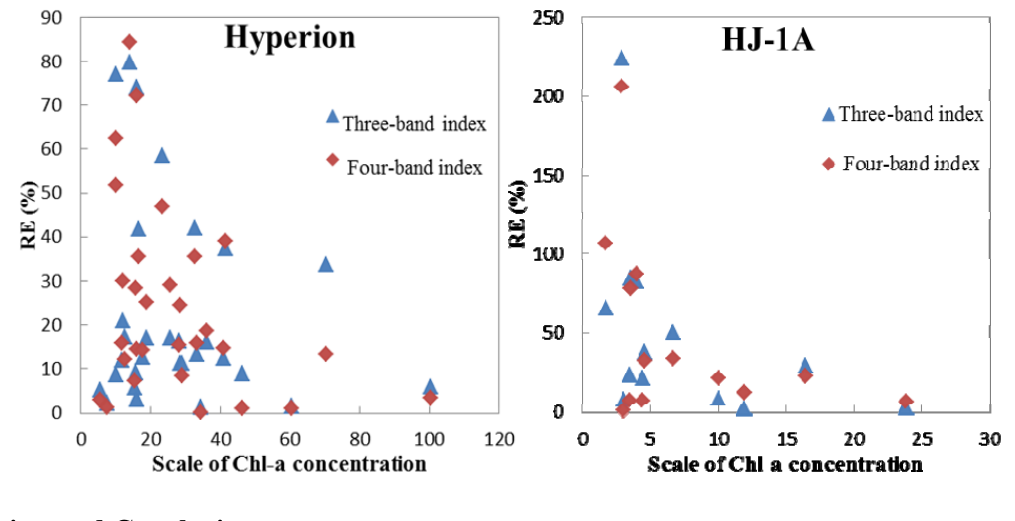
Figure 8. The relationships between RE and Chl- a concentration. ( a ) Hyperion data; ( b ) HJ-1A